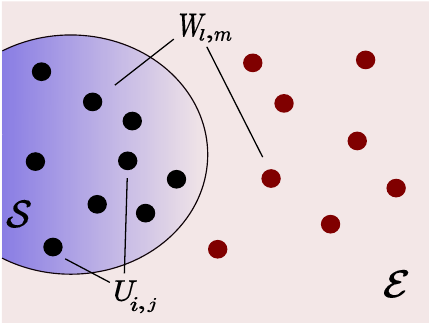
Figure 1 . Pictorial representation of the model introduced in section 2. We consider a system and an environment consisting of N and M qudits respectively. The evolution is driven by the E continuous limit of a random quantum circuit which implements a fast-scrambling dynamics for with a tunable coupling between and . At each in(cid:12)nitesimal time step (cid:1) t a random unitary S E operator U i;j is applied to randomly chosen qudits in with probability p 1 = N(cid:21) 1 (cid:1) t , while a swap S W l;m between a qudit in the system and one in the environment (randomly chosen) is applied with probability p 2 = (cid:21) 2 (cid:1) t